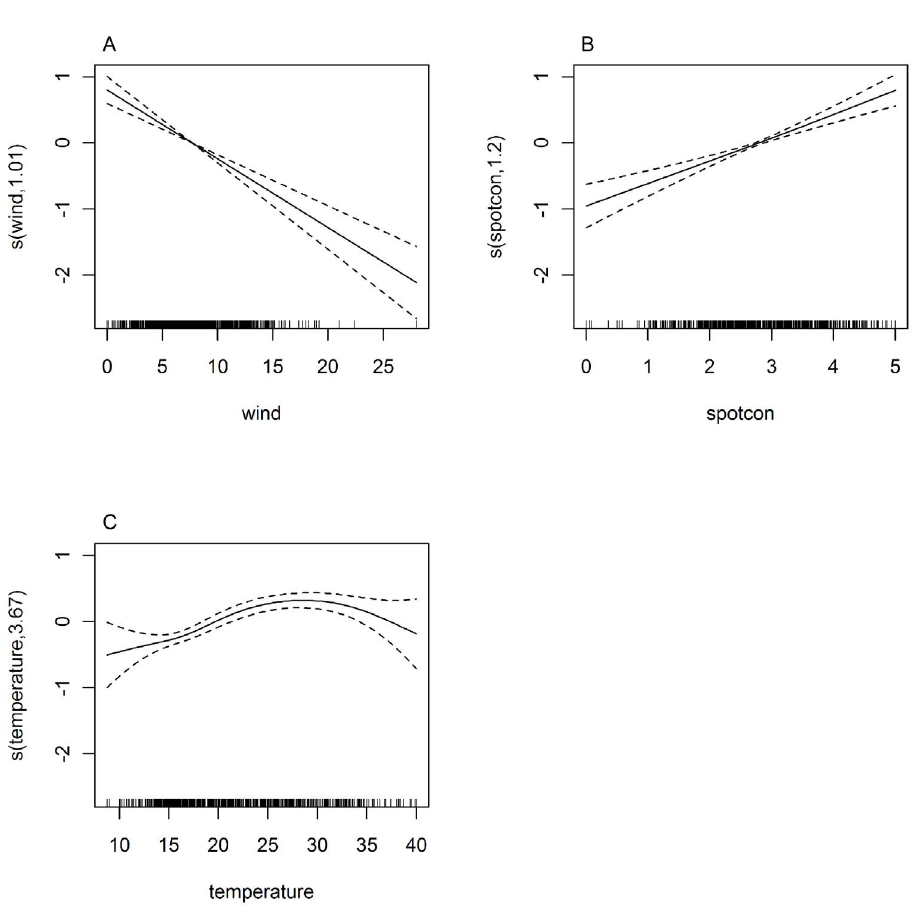
Fig. 3. Estimated smooth relationships with 95% CI’s between log(biomass spotted/search effort) and covariates. Vertical axis labels show covariate and effective degrees of freedom of the smooth (e.g. s(wind, 1.01) in panel A). A) ‘wind’ (windspeed in knots), B) ‘spotcon’ (spotting conditions between 0 and 5) and C) ‘temperature’ (mean air temperature in ˚ C). The ‘rug’ on the horizontal axis shows where datapoints are